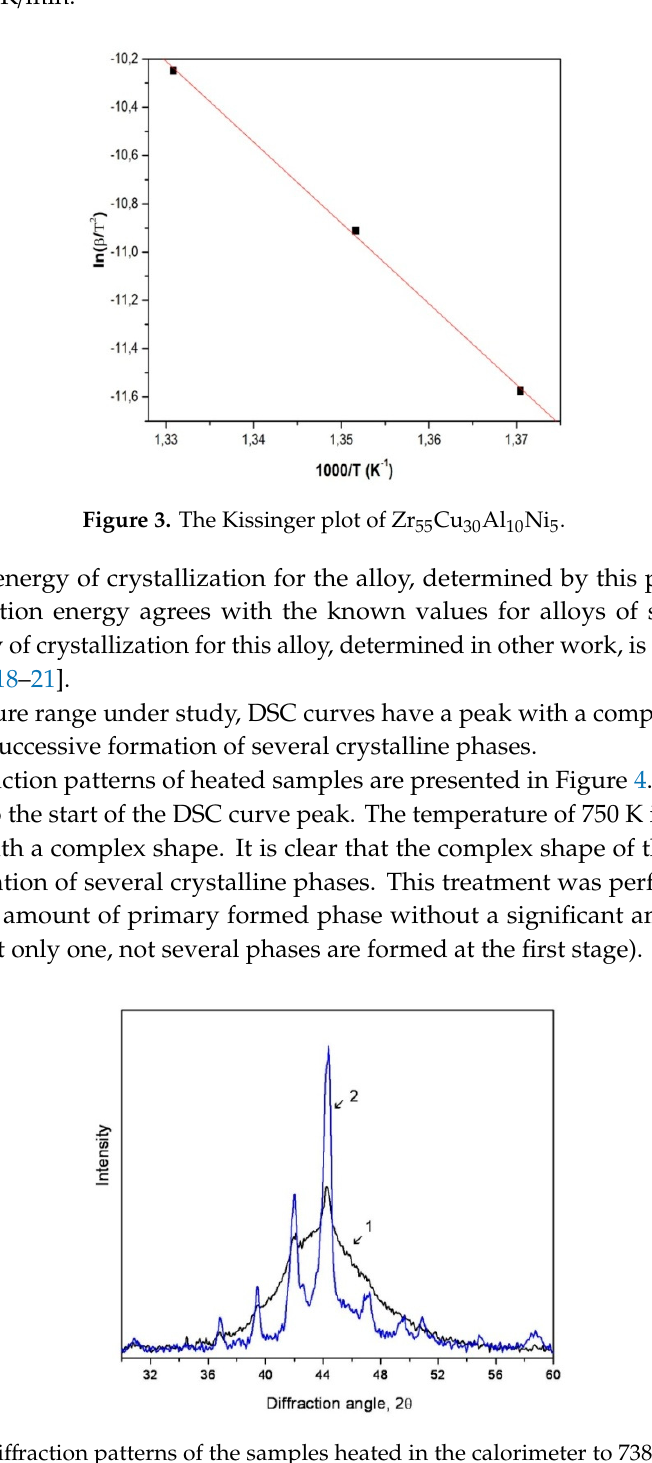
Figure 4. X-ray diffraction patterns of the samples heated in the calorimeter to 738 (1) and 750 (2) K ( С o K α